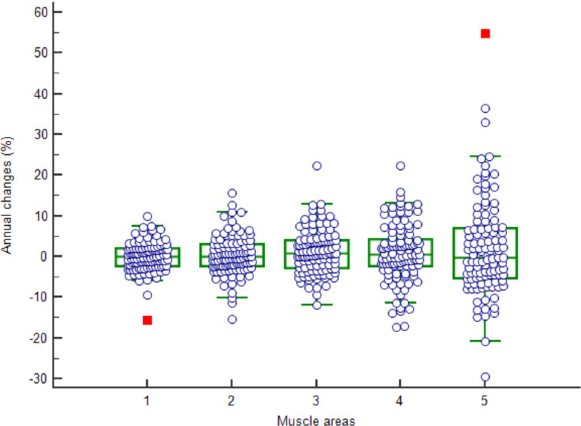
Figure 2. Box-and-Whisker plots regarding annual changes (%) of variable muscle areas ([1] skeletal muscle area at 3rd lumbar vertebra level, 0.0725 ± 3.5308%; [2] skeletal muscle area at 1st lumbar vertebra level, 0.3300 ± 4.7365%; [3] = erector spinae muscle area at 12th thoracic vertebra level, 1.1614 ± 5.3488%; [4] chest wall muscle area at carina level, 0.8622 ± 7.1192% [5]; pectoralis muscle area just above aortic arch level, 2.0202 ± 11.8910%).